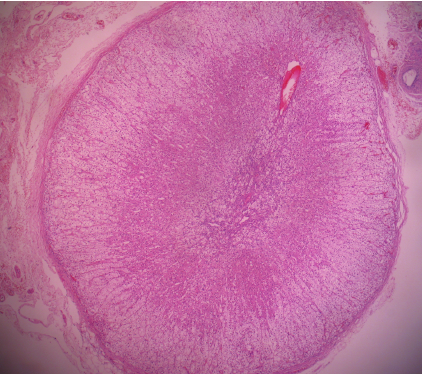
Figure 1: Lobulated mass, filling the pelvis and indenting uterus in MRI.